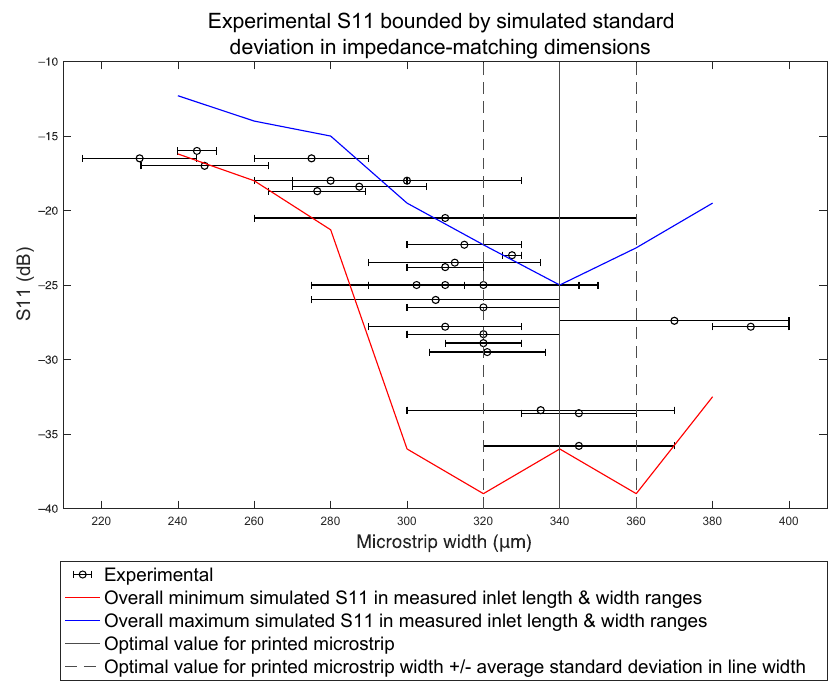
Figure 6. Experimental data bounded by simulation models including variation of both printed inlet length and inlet width. These bounds encapsulate the S11 results that can be expected given the level of variation in the impedance matching inlet dimensions. The average standard deviation of 20 µ m in printed microstrip width along any given microstrip is depicted by the dashed lines. The figure demonstrates that a microstrip designed at 340 µ m will produce a more consistent antenna design given experimentally determined print variability.